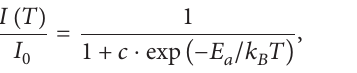
Figure 9: Emission spectra ( ̃𝜐 (0.5% Eu 2+ ), and 5 (1.0% Eu 2+ ) at 10K.